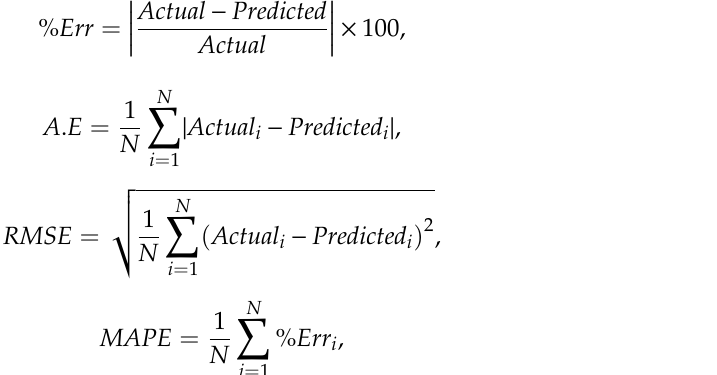
Figure 9. Comparison of performance of all the methods used for energy consumption forecasting. Furthermore, the absolute percentage of error (% Err ), the absolute average error ( A.E ), root mean square error ( RMSE ), and mean average percentage error ( MAPE ) for the prediction systems have been calculated using (25), (26), (27), and (28), respectively. The absolute percentage error shows the percentage of prediction error per day total consumption and helps determine the maximum error that occurs within the considered time period. The absolute average error predicts the average error of prediction from the actual consumption with the considered time periods. Similarly, the RMSE and MAPE shows the mean error and mean percentage of error over a considered time period. These error methods are very standard for the comparison of performance. The lower values of these errors mean the system predicts very close to the actual predictions. Therefore, these errors are used to evaluate the best system performance and these errors have been used as performance indices in this